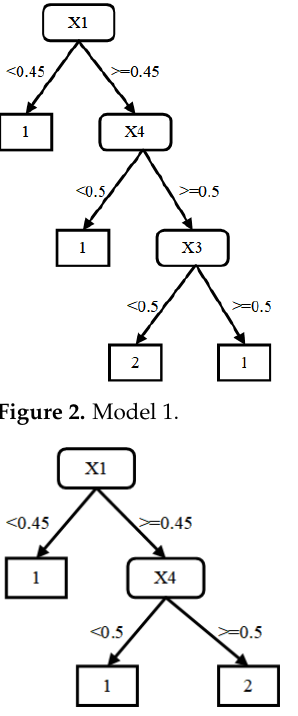
Figure 3. Model 1(a) limiting the number of leaf node